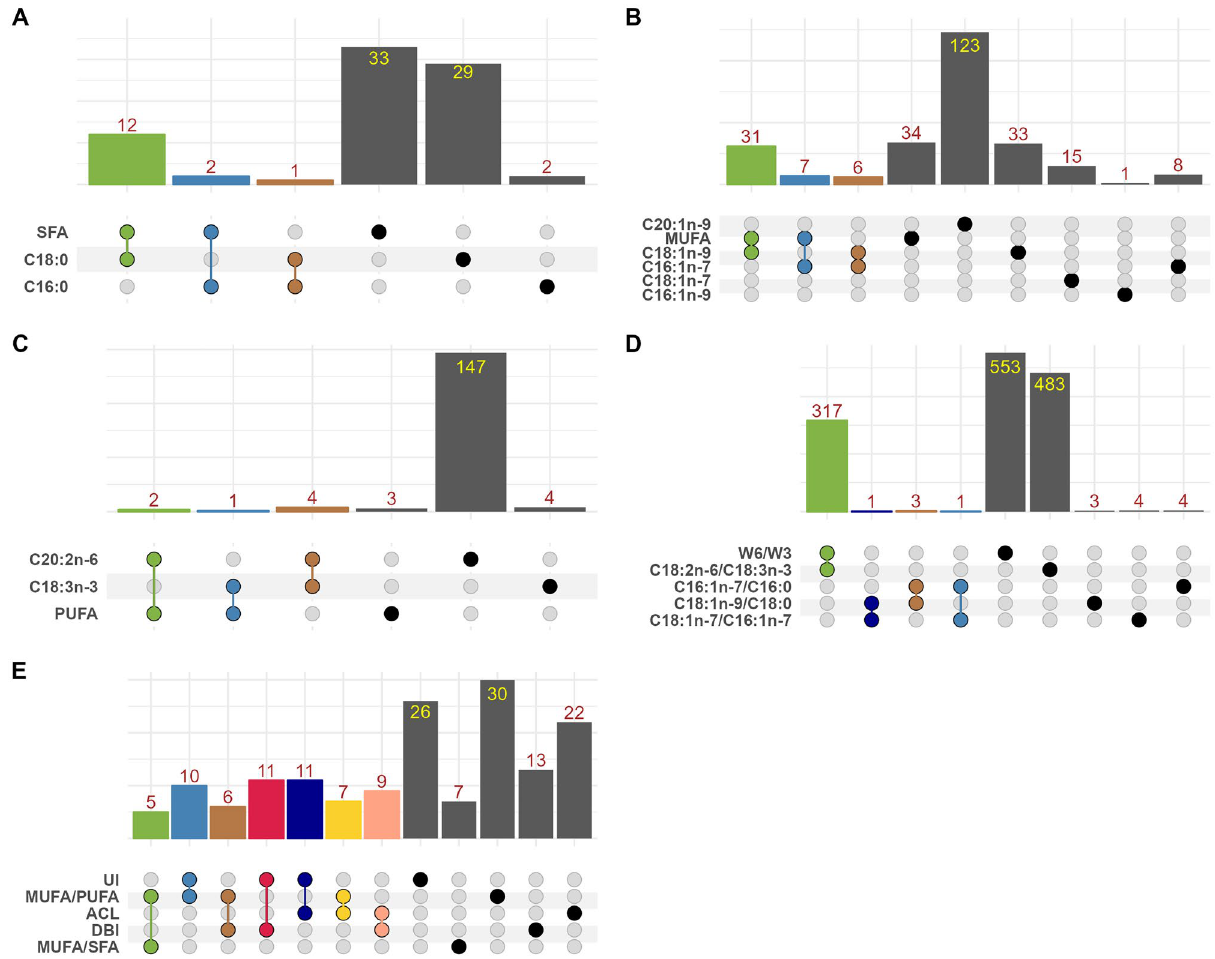
Figure 1. Analysis of overlapping and total number of associated genes by category of traits. The upset diagram (from left to right) shows the shared fraction (intersection size) of associated genes per pair of traits (colored bars), as well as the number of associated genes in each trait (gray bars). ( A ), ( B ), ( C ), ( D ) and ( E ) represents the group of saturated FAs, monounsaturated FAs, polyunsaturated FAs, FA ratios, and metabolic ratios and indices,